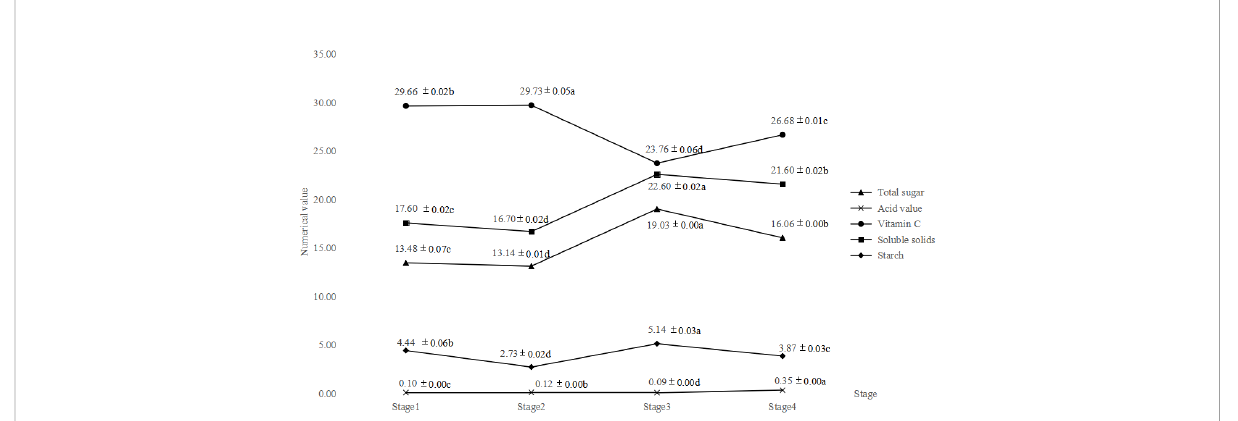
FIGURE 3 Changes of main nutrient components in the pulp at different developmental stages of